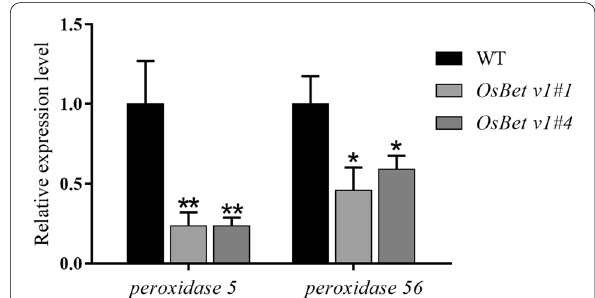
Fig. 7 RT-qPCR analysis of the expression levels of peroxidase 5 and peroxidase 56 in OsBet v1 knockout mutants and wild-type (WT) plants. Data are presented as the mean SD. The experiments were ± performed three times with similar results, and three technical replicates for each reaction. * P < 0.05, ** P < 0.01, Student’s t